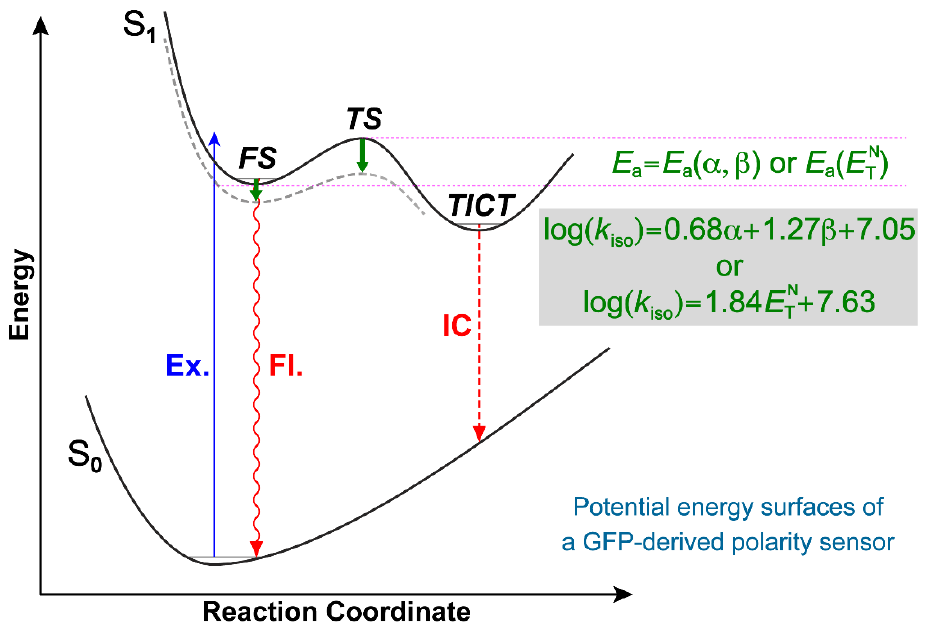
Figure 4. Schematic of PESs for compound 1 governing the polarity effect. The dashed gray curve depicts the shifted excited-state PES due to strengthened H-bonding interactions between the chro- mophore and solvent, leading to an effectively reduced energy barrier. The reaction coordinate could mainly consist of the dimethylamine twisting angle. Abbreviations: Ex., excitation; Fl., fluorescence; IC, internal conversion; TS, transition state. These oversimplified 2D PESs capture the essence of the working mechanism of this polarity sensor.